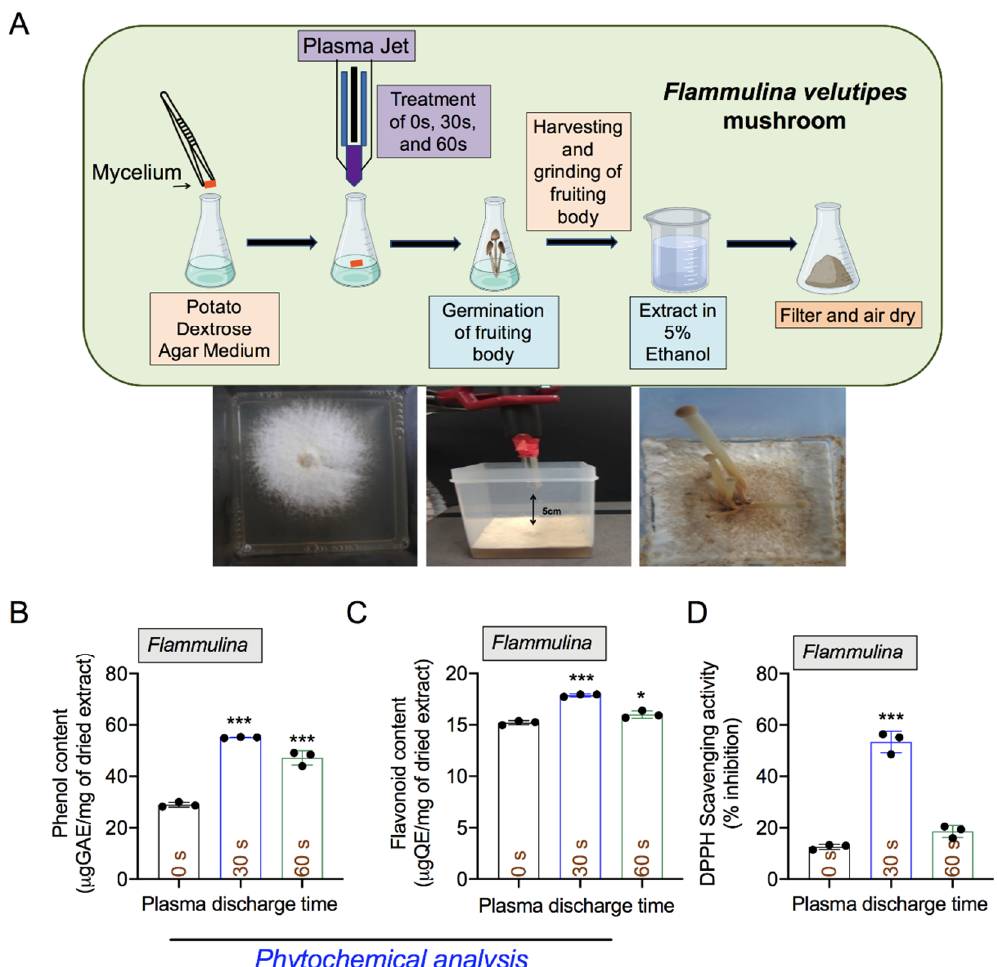
Figure 2. Extract preparation from plasma-treated / untreated mushrooms ( F. velutipes ) and their characterization. ( A ) Experimental scheme for extract preparation from plasma-exposed and unexposed mushroom; ( B – D ) Measurement of phenolic, flavonoid, and antioxidant properties in extracts prepared from plasma-treated (30 s and 60 s) and untreated (0 s) mushrooms. * p < 0.05 and *** p < 0.001. Untreated sample was used as a negative control for normalization.